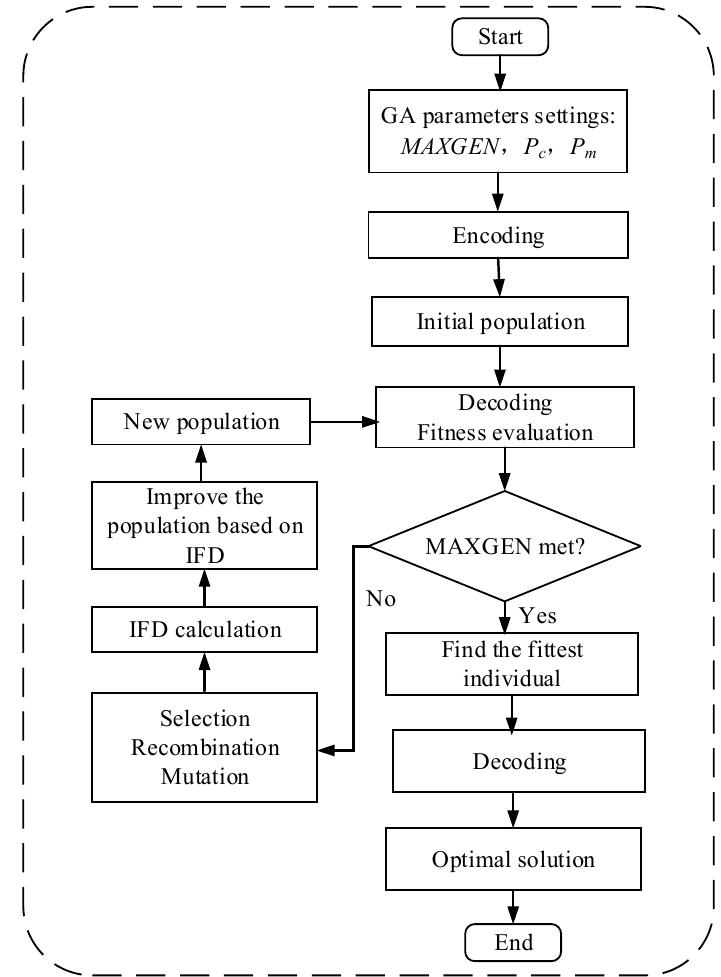
Figure 3. Flowchart of a genetic algorithm (GA) based on the IFD of the solution.